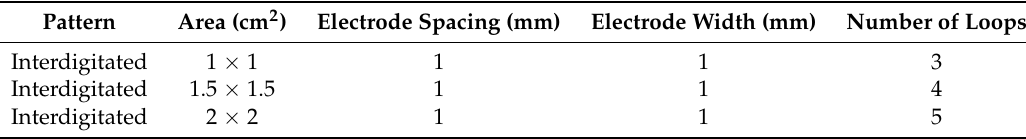
Table 4. Parameters of FEF (fringing electric field) sensors in Figure